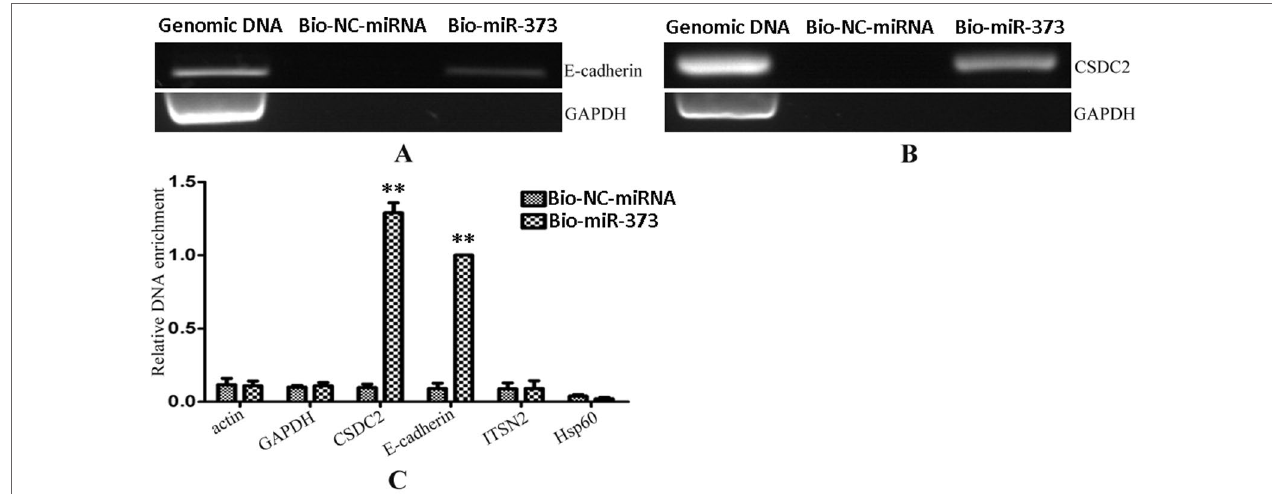
FIGURE 3 | Promoters of E-cadherin and CSDC2 can be pulled down by biotinylated miR-373. Bio-miR-373 or bio-NC-miRNA was transfected into MCF-7 cells for 24 h. Then cells were harvested, and the DNA fragments were enriched via DNA–miRNA pull-down assay. (A) The enrichments of E-cadherin promoter were measured by semi-quantitative PCR. (B) The enrichments of CSDC2 promoter were measured by semi-quantitative PCR. (C) Real-time PCR was performed to detect the enrichments of E-cadherin and CSDC2 promoters. U6 fragments added in the samples were taken as an endogenous control. n = 3, ** P < 0.01 compared with the sample transfected with